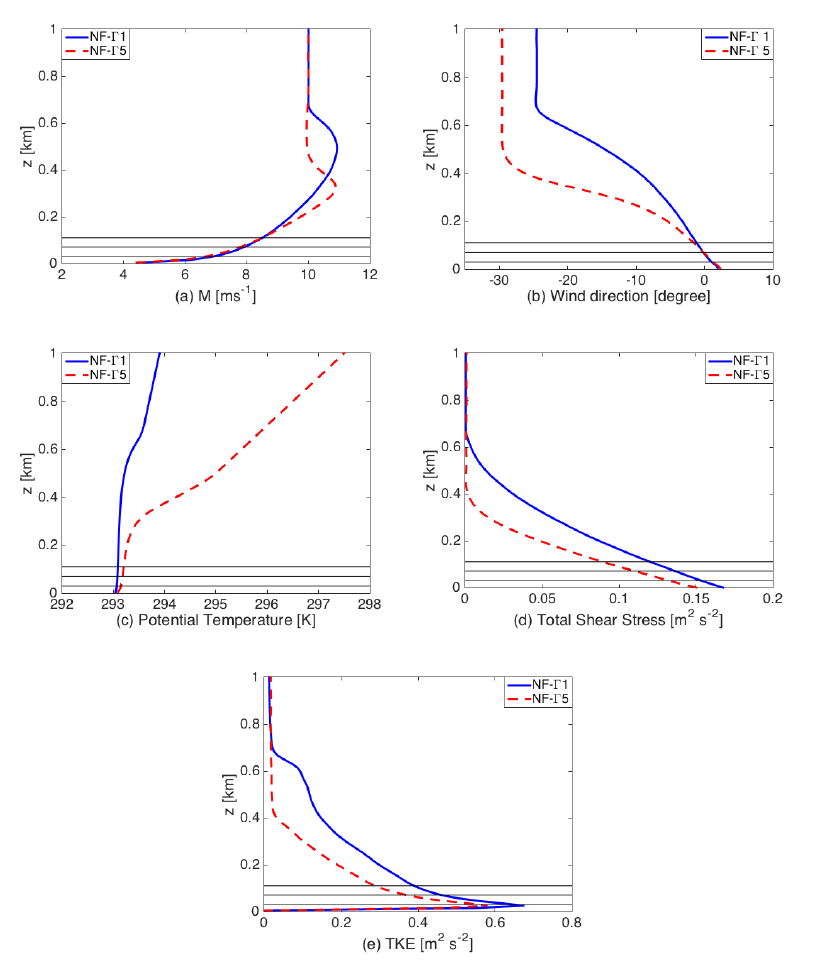
Figure 1. Vertical profiles of the horizontally-averaged ABL flow characteristics in the no-farm cases: ( a ) mean velocity magnitude M ; ( b ) wind direction; ( c ) potential temperature; ( d ) total Reynolds shear stress (( u (cid:48) w (cid:48) ) 2 + ( v (cid:48) w (cid:48) ) 2 ) 1/2 ; and ( e ) TKE. The black solid lines represent the top-tip, hub, and bottom-tip heights.